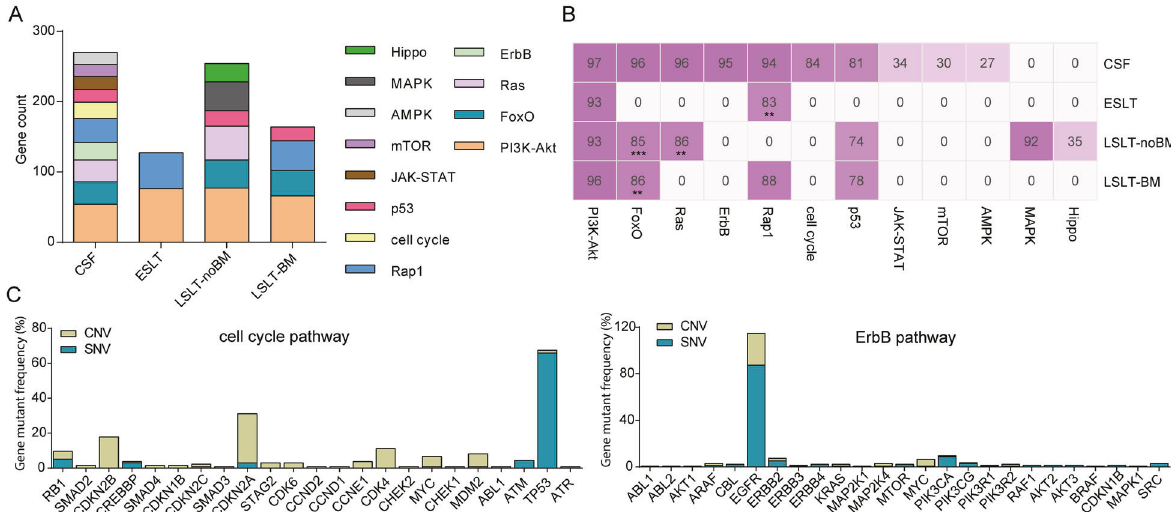
Fig. 5 Pathway differences between CSF and primary lesions. A Remarkable enrichment of KEGG pathways in each group according to FDR < 0.1. The vertical axis indicates gene count. Gene count means the number of mutated genes enriched in one term. B Heatmap of alteration frequency of identi fi ed pathways. The horizontal axis represents signal pathways, and the fi gures indicate mutation percentages. Differences with signi fi cant P values are labeled (two-sided Fisher ’ s exact test). ** P < 0.01, *** P < 0.001. C Gene alterations (including SNV and CNV) of highly frequent and unique pathways in CSF samples. The vertical axis shows gene mutation frequency.